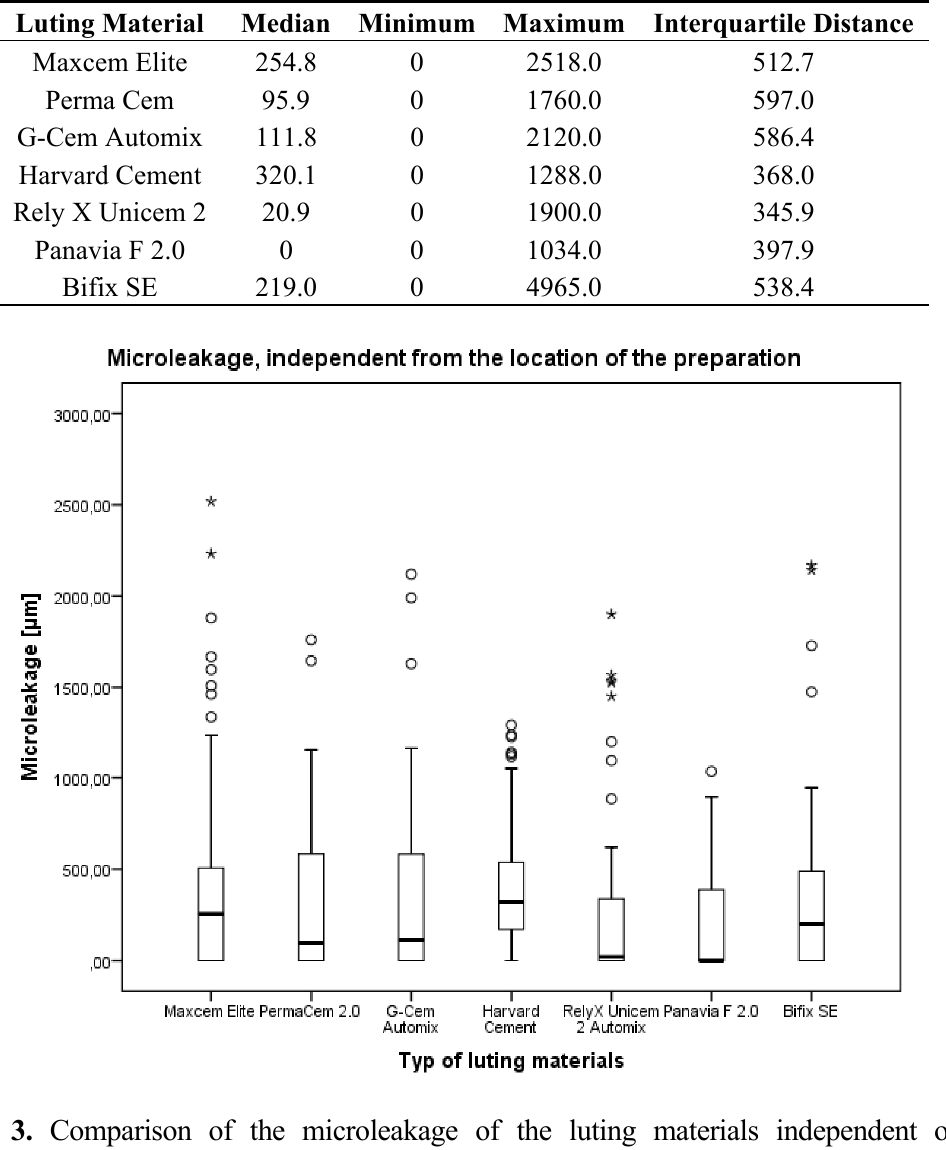
Figure 3. Comparison of the microleakage of the luting materials independent of the preparation location. Boxes indicate the 50% percentile. This line within the box indicates the median and the bars indicate the 75% percentile. Circles and asterisks indicate outliers and extreme